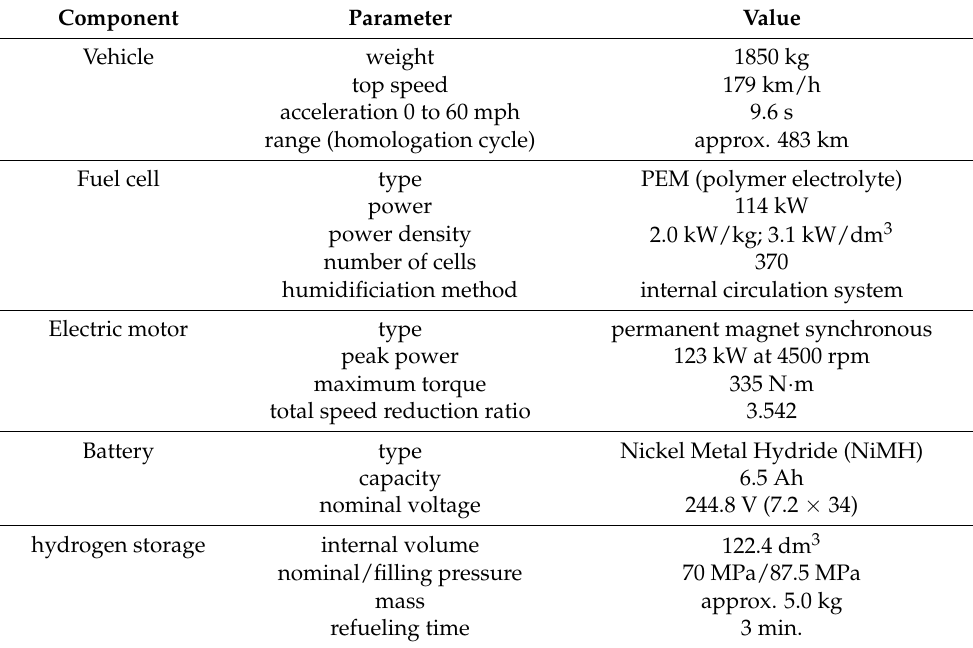
Table 1. Toyota Mirai powertrain system